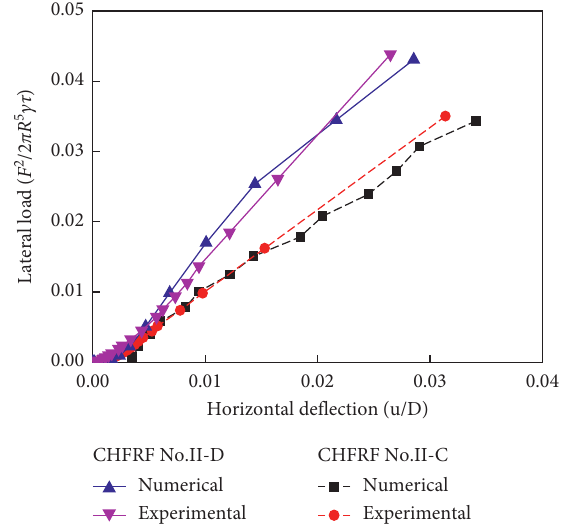
Figure 17: Comparison between test and numerical simulation results.